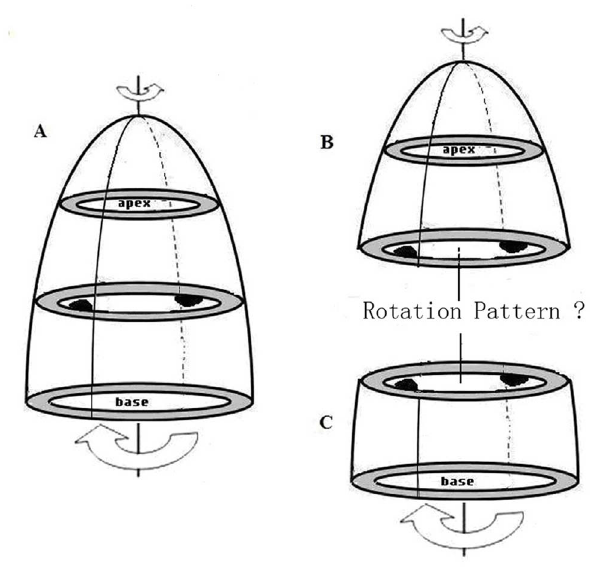
Figure 2. Divide the LV into two parts at the papillary muscle short-axis level.